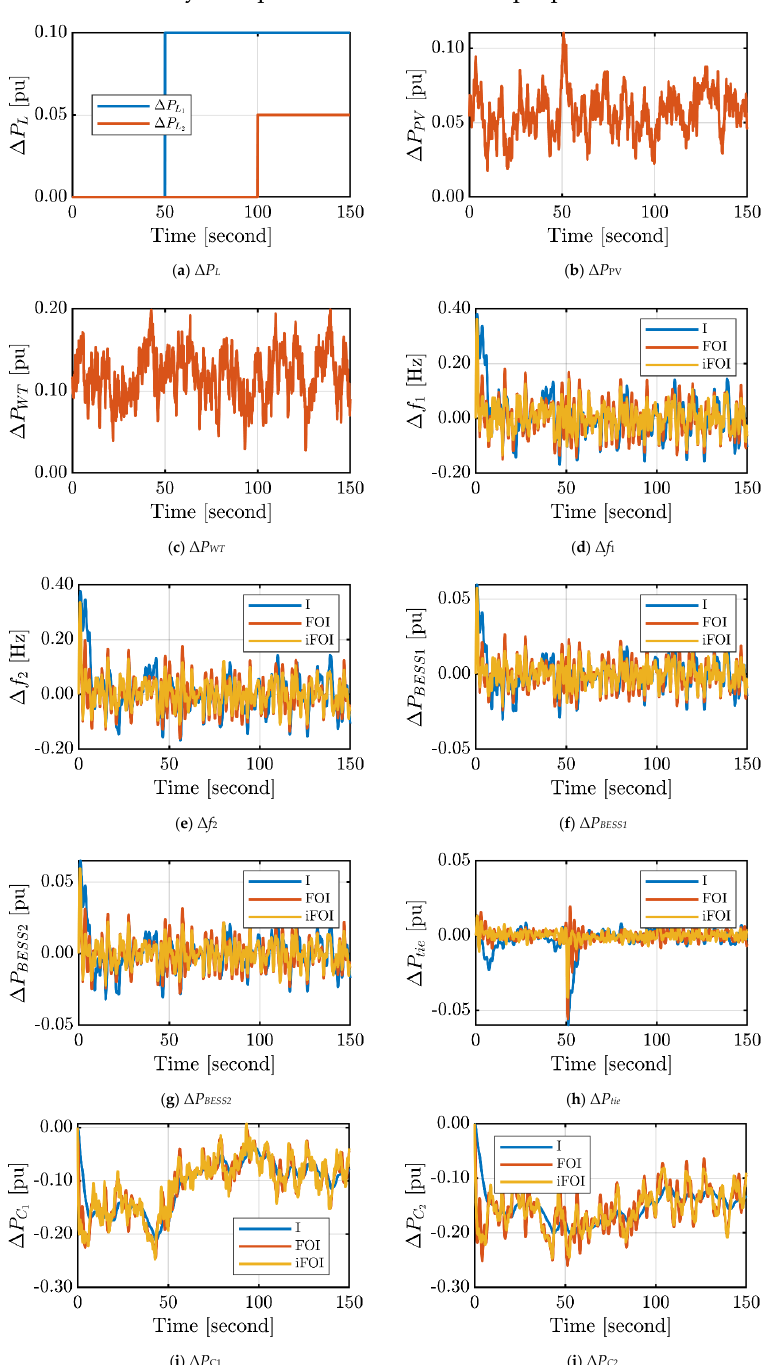
Figure 9. Dynamic response of the two ‐ area power system in case 2.